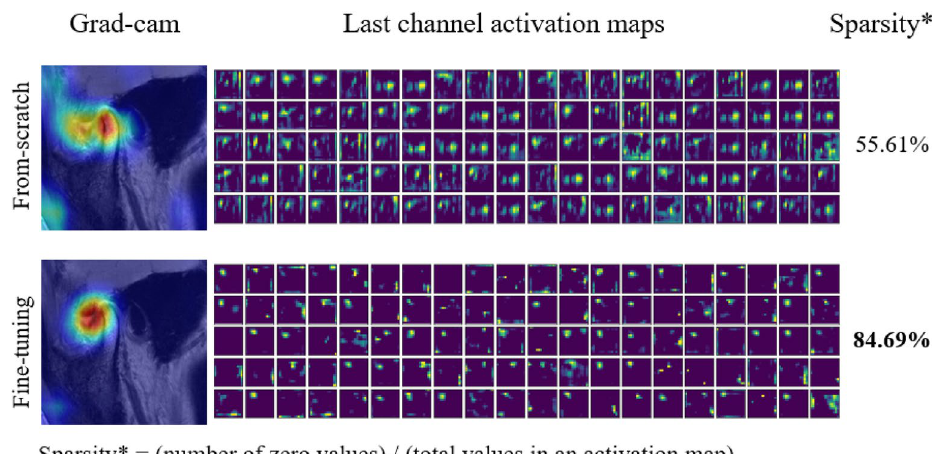
Figure 6. Last channel activation maps of both models using the same image. The first and second rows show the results of the from-scratch and fine-tuning models, respectively. Highly sparse activations are learned in the fine-tuning model, which provides a clearer Grad-CAM